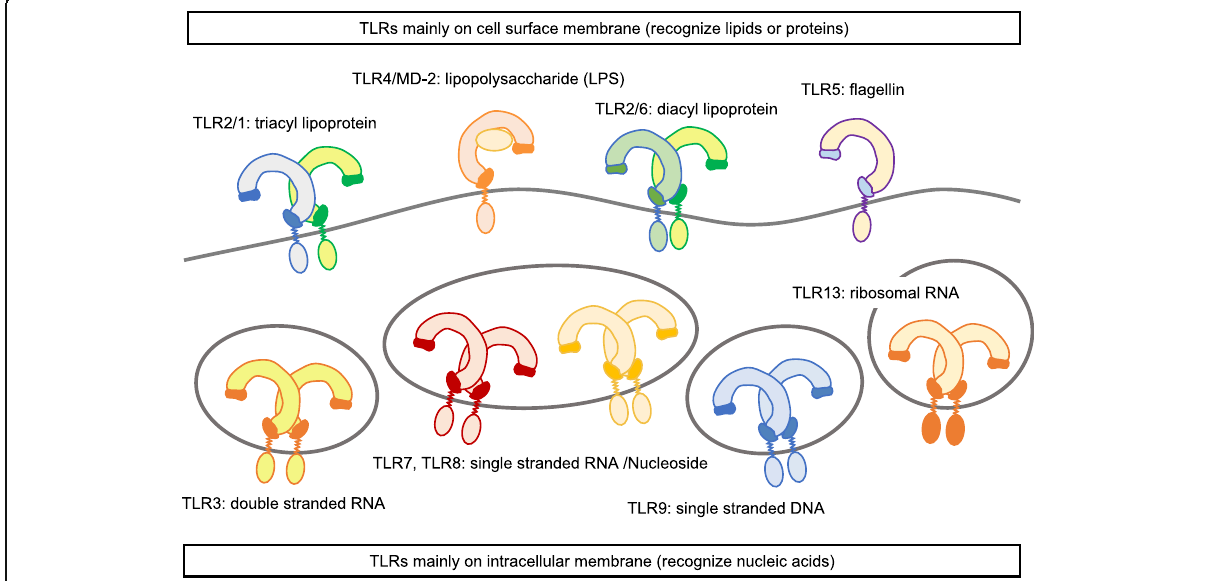
Fig. 1 Subcellular distribution and ligands of TLRs. TLR2/TLR1 heterodimer, TLR2/TLR6 heterodimer, TLR4/MD-2 complex, and TLR5 are mainly localized on plasma membrane and recognize lipids or proteins. TLR3, TLR7, TLR8, and TLR9 are mainly localized on the membrane of intracellular particle and recognize nucleic